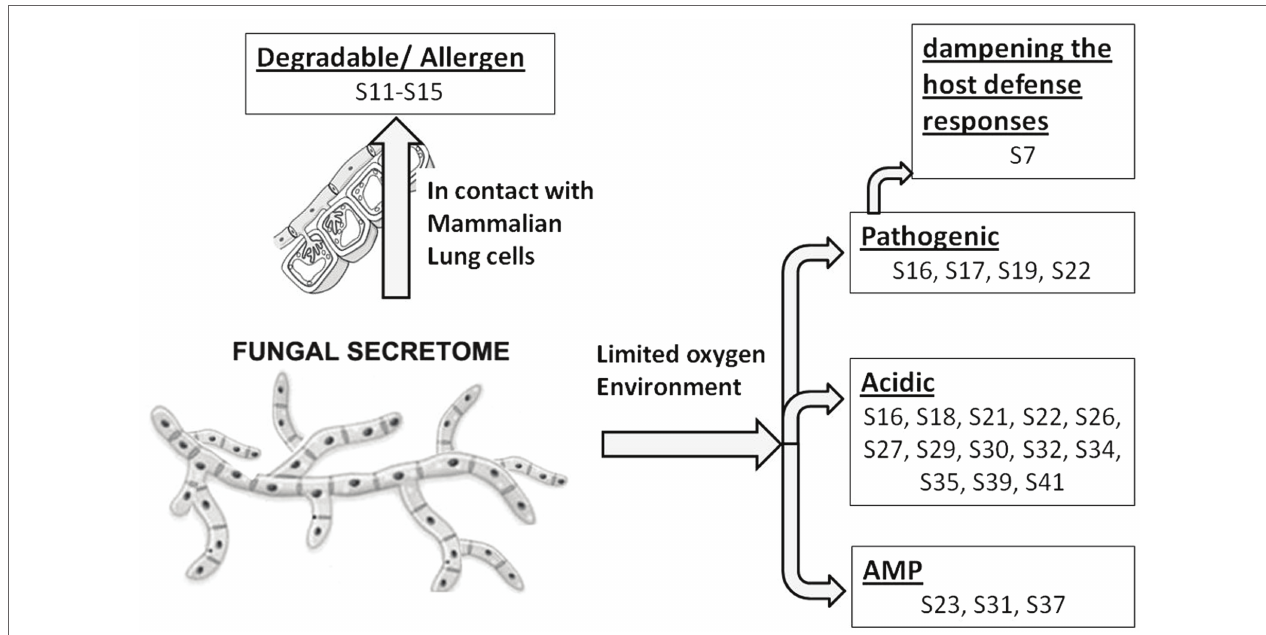
FIGURE 2 | Model representing R. arrhizus var. delemar secretome analysis in response to growth at two different environmental conditions (initiation- and dissemination-like